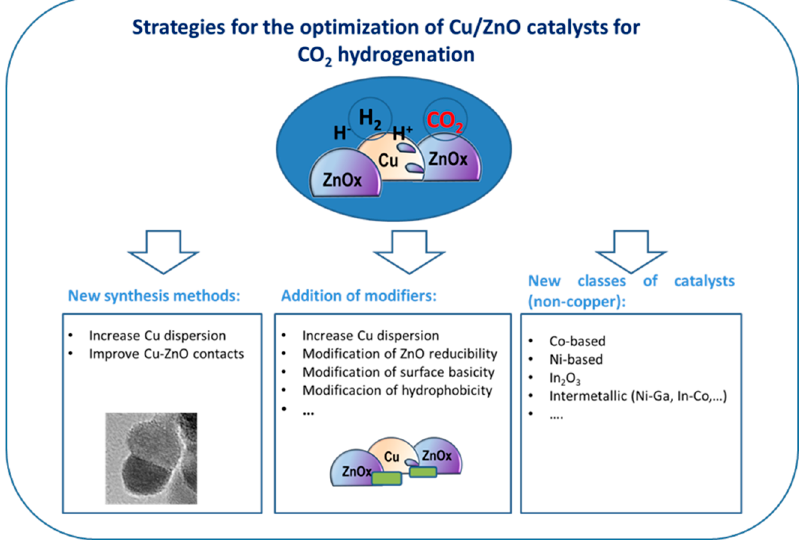
Figure 5. Main strategies followed for the optimization of Cu/ZnO catalysts applied for methanol synthesis from CO 2 hydrogenation .